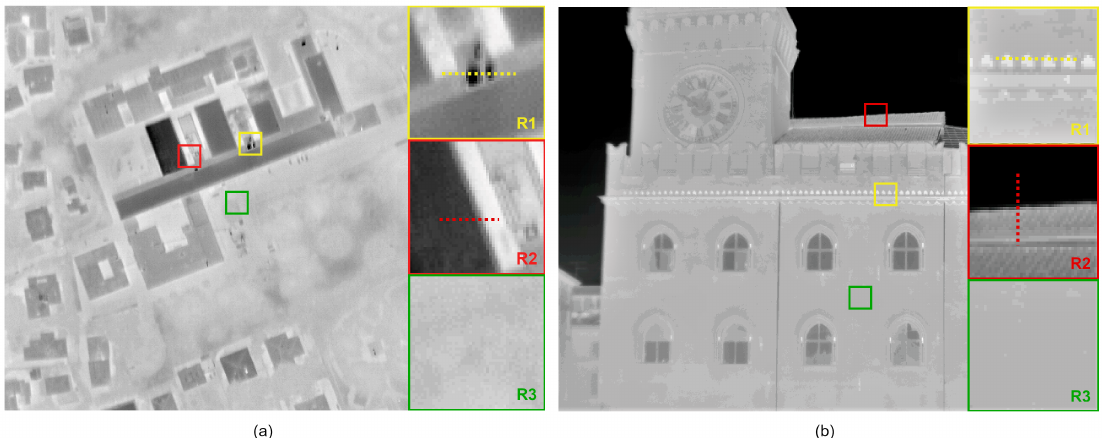
Figure 2. ( a ) High-resolution 480 × 640 I1 image with regions of interest (ROI) R1, R2, and R3 for the quantitative analysis of super-resolution results. ( b ) High-resolution 480 × 640 I2 image with regions of interest (ROI) R1, R2, and R3 for the quantitative analysis of super-resolution